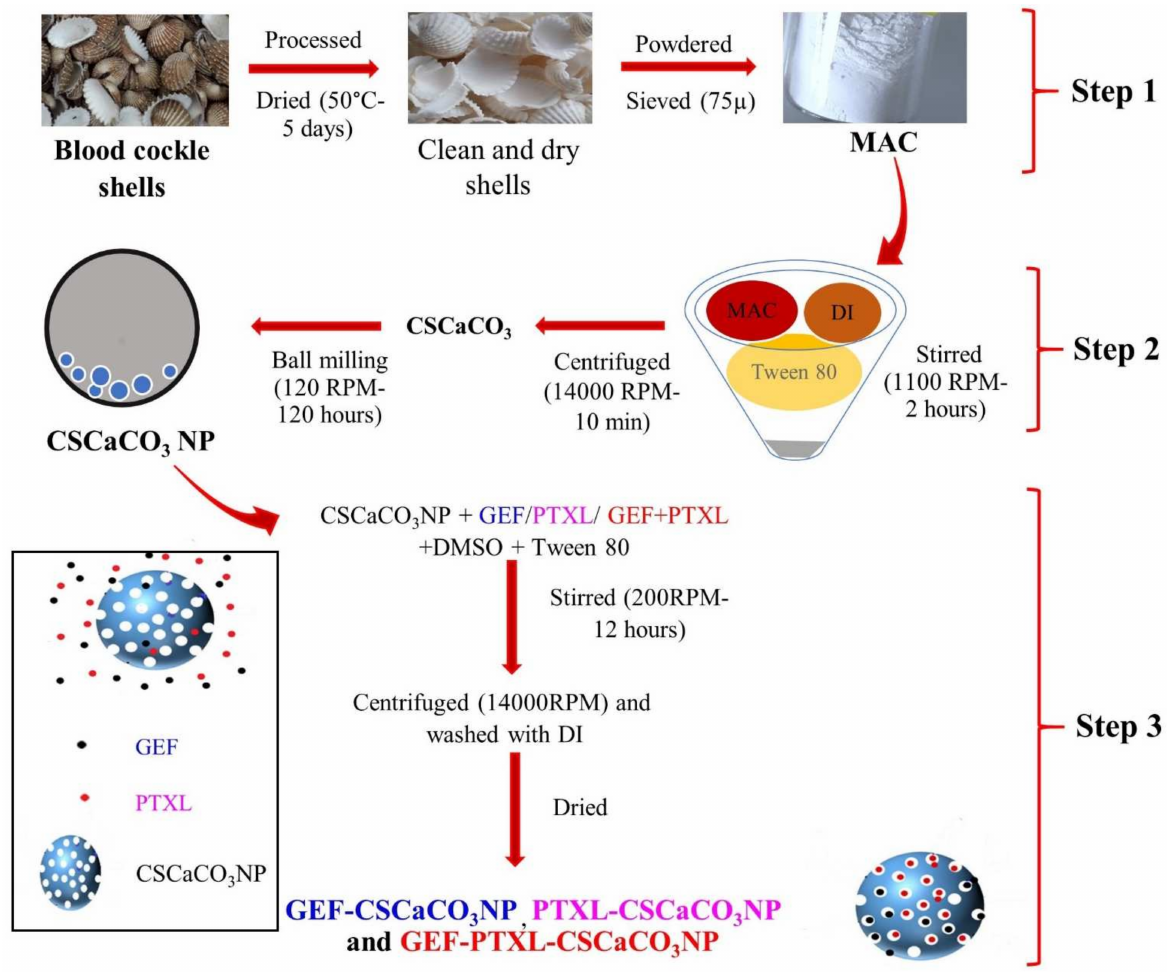
Figure 1. Schematic diagram showing the step-by-step synthesis of Blood cockle shell derived CaCO 3 nanoparticles. Step 1: Transformation of blood cockle shells into MAC, Step 2: Synthesis of CSCaCO 3 NP from MAC, and Step 3: Synthesis of Mono drug-loaded GEF-CSCaCO 3 NP, PTXL-CSCaCO 3 NP, and dual drug-loaded GEF-PTXL-CSCaCO 3 NP. MAC, micron-size aragonite calcium carbonate particles; DI, Deionized water; CSCaCO 3 NP, Blood cockle shell derived CaCO 3 nanoparticles; GEF, Gefitinib; PTXL, Paclitaxel; GEF-CSCaCO 3 NP, GEF loaded Blood cockle shell derived CaCO 3 nanoparticles; PTXL- CSCaCO 3 NP, PTXL loaded Blood cockle shell derived CaCO 3 nanoparticles and GEF-PTXL-CSCaCO 3 NP, GEF and PTXL loaded Blood cockle shell derived CaCO 3